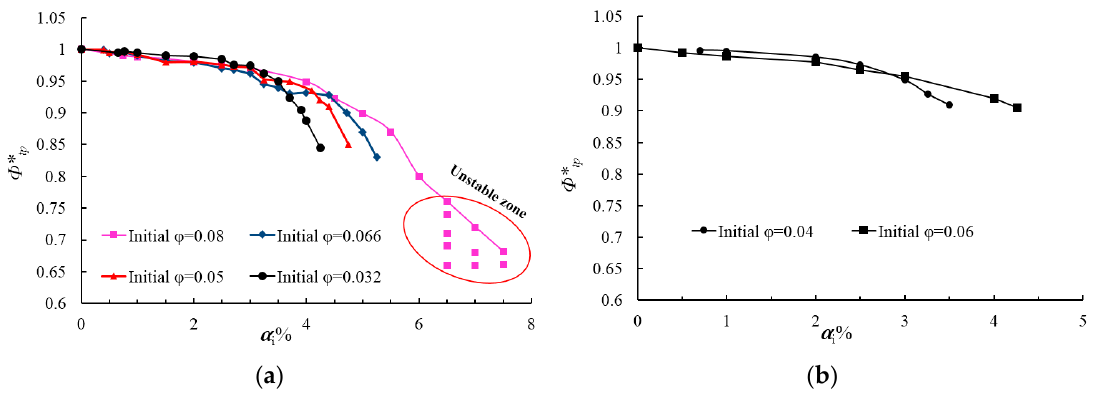
Figure 8. Flow coefficient degradation ratio for two rotational speed: ( a ) n = 1450 r/min and ( b ) n = 1000 r/min.